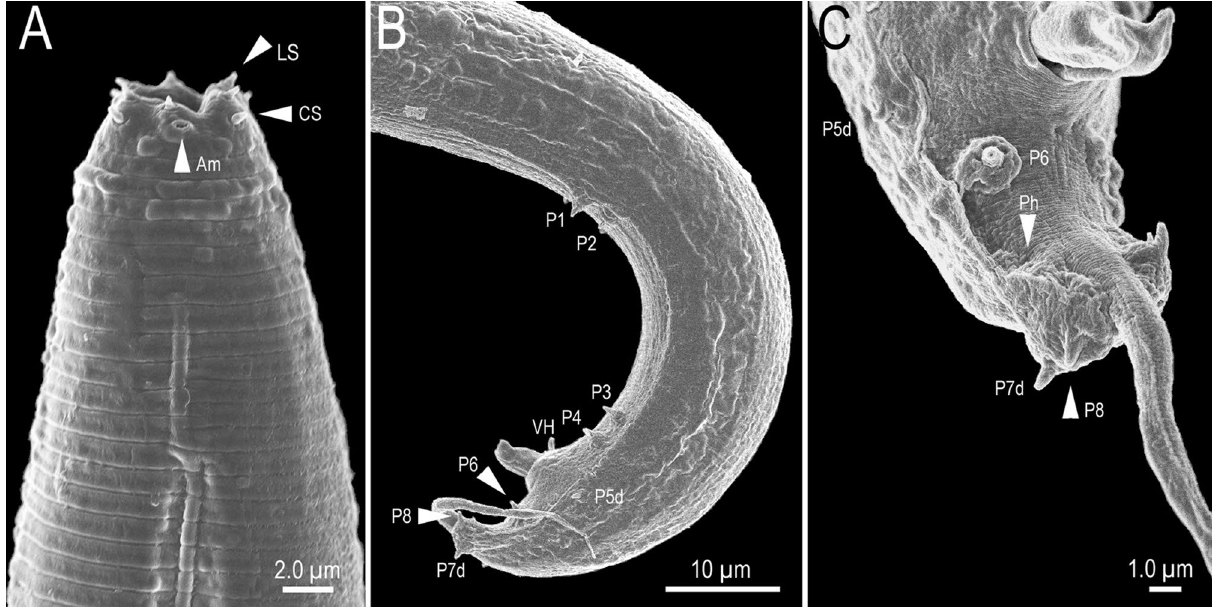
Figure 3. Tokorhabditis tufae n. gen., n. sp. ( A ) Left lateral view of head region of adult hermaphrodite; ( B ) Left lateral view of whole male tail; ( C ) Male tail tip region in right subventral view. Amphid (Am), labial sensilla (LS), cephalic sensilla (CS), papillae (P + number, and “d” indicates dorsally or laterally opened papillae), ventral precloacal hook (VH) and phasmid (Ph) are by sphincter muscle at vaginal-uterine junction. Young females/hermaphrodites carrying usually none or only one embryo in each uterus, in old individuals, many (more than 10) well-developed embryos and juveniles are present in an expanded uterus, rendering other gonadal structures vague. Two subventral glands and one dor- sal rectal gland observed surrounding intestine-rectum junction and anterior part of rectum. Rectum approxi- mately same as anal body diam. Anus a short horizontal slit at surface; posterior anal lip expands slightly in lateral view. A pair of phasmids located laterally at 1.3–1.9 anal body diam. Or 13–21% of tail length posterior to anus. Tail forming elongate conoid, smoothly tapered to finely elongated conical tip but not filiform. Dauer juveniles. Actively move around on substrate (Supplementary Data 2). Body cylindrical, straight or weakly ventrally arcuate when heat-relaxed. Cuticle thin, smooth, coarsely and shallowly annulated, with two lines of conspicuous lateral field. Anterior end dome-shaped, continuous with body. Amphids with oval-shaped openings, conspicuous, at the level of the posterior end of cheilostom. Labial sensilla observed as refractive dots, inconspicuous. Initially ensheathed in coarsely annulated J2 cuticle; border between J2 cuticle and dauer body transparent. Stoma narrow, approximately 10 times deeper than diam., cylindrical, weakly sclerotized, anterior end closed; separations among cheilostom, gymnostom, and stegostom not clear, but stegostom distinguished by the presence of pharyngeal sleeve. eta- and telostegostom, where stoma meets pharyngeal lumen, more scle- rotized than anterior regions of stoma. Procorpus cylindrical, not well-developed, occupying less than 1/3 of corresponding body diam. Metacorpus slightly expanded to form median bulb. Isthmus slightly slenderer than procorpus. Posterior end of corpus (pharynx) forms weakly developed basal bulb with weakly developed duplex haustrulum, smoothly connected to cardia. Procorpus plus metacorpus (anterior pharynx) slightly longer than isthmus plus basal bulb (posterior pharynx). Cardia funnel-shaped, seemingly closed. Nerve ring not well-devel- oped, surrounding the middle part of isthmus. Excretory pore conspicuous, on ventral side of body, at level of middle to posterior parts of isthmus. Excretory tube extending anteriorly, and then reflexing posteriorly. Excre- tory cells sometimes observed, but not always clear. Genital anlagen visible ventrally at mid-body; cells linearly arranged, but number of cells not clearly observed. Two subventral glands and one dorsal gland observed at intestine-rectum junction and anterior part of rectum. Rectum approximately same as anal body diam. In length. Tail more or less elongate conoid with pointed tip.